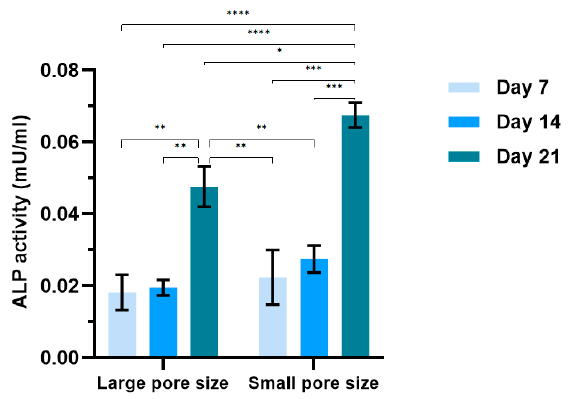
Figure 6. ALP activity of hMSCs on large and small pore size SiOC(N) ceramic scaffold in osteogenic medium for 7, 14, and 21 days. n = 8; * p < 0.05; ** p < 0.01; *** p < 0.001; **** p < 0.0001.